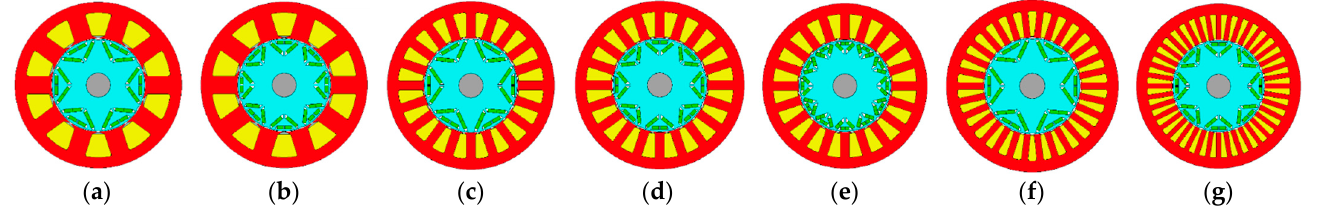
Table 1. Winding coefficient under different slot/pole combination.